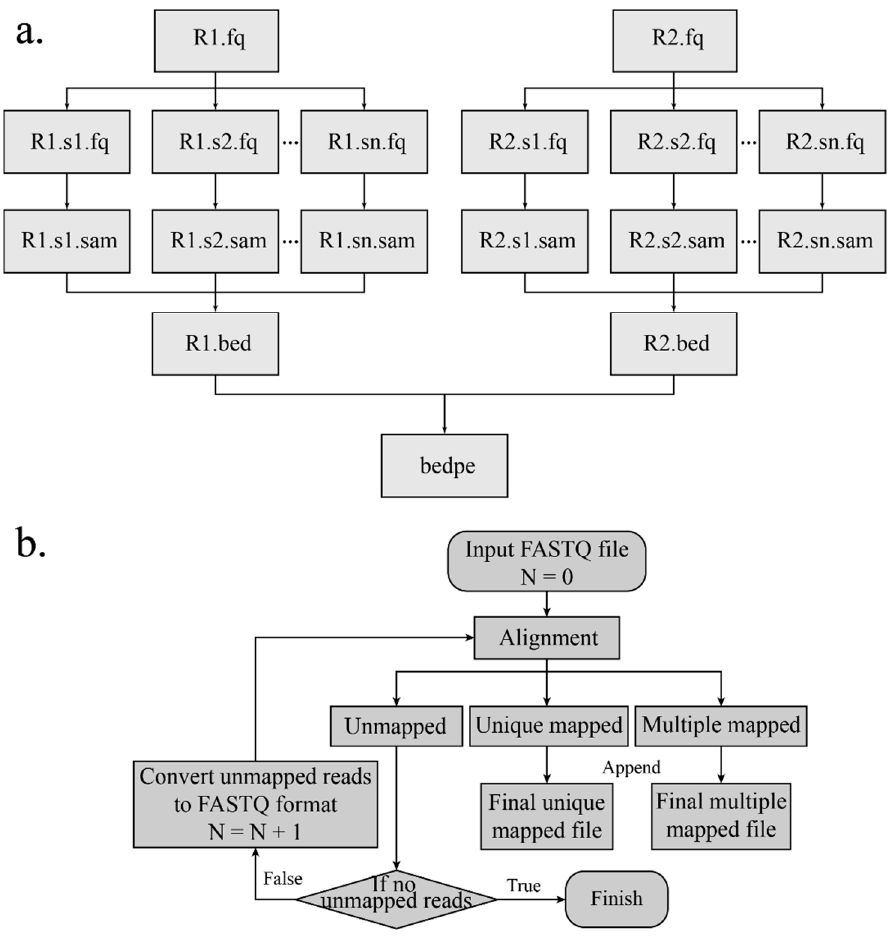
Figure 3. Flow chart of mapping and iterative mapping. ( a ) Raw data are split into several chunks, and the alignment results of different chunks are merged after pairing. ( b ) The flowchart shows the detailed steps of iterative mapping. N represents the maximum edit distance of the Burrows-Wheeler Alignment (BWA).